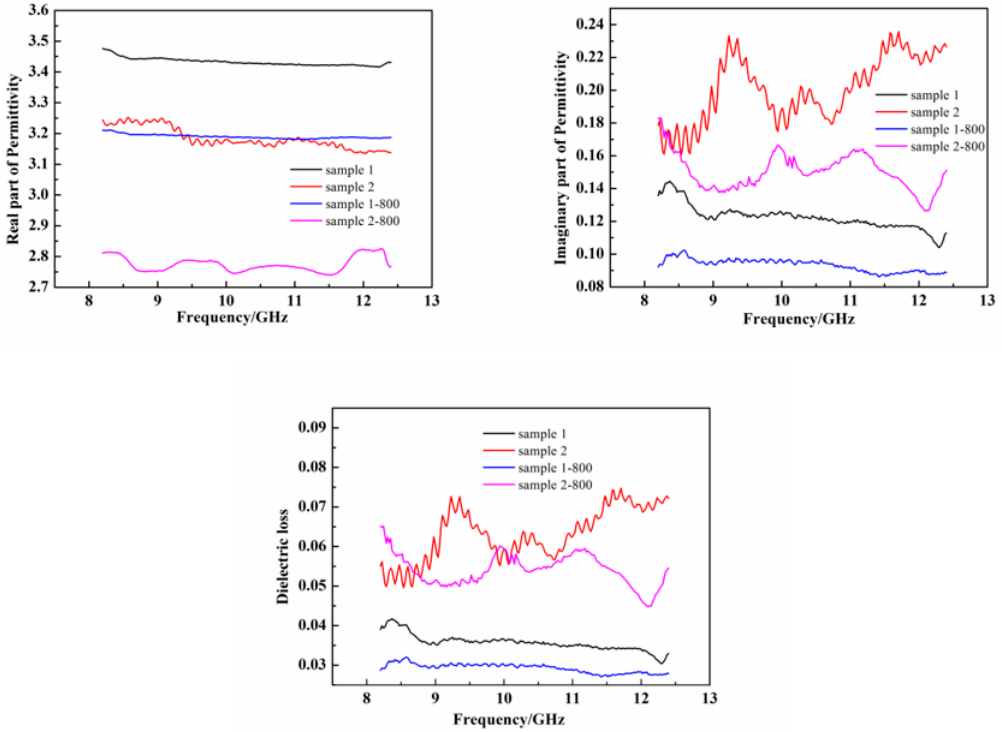
Figure 11. Dielectric properties of two fiber/resin composites in X-band, prior to and following annealing.